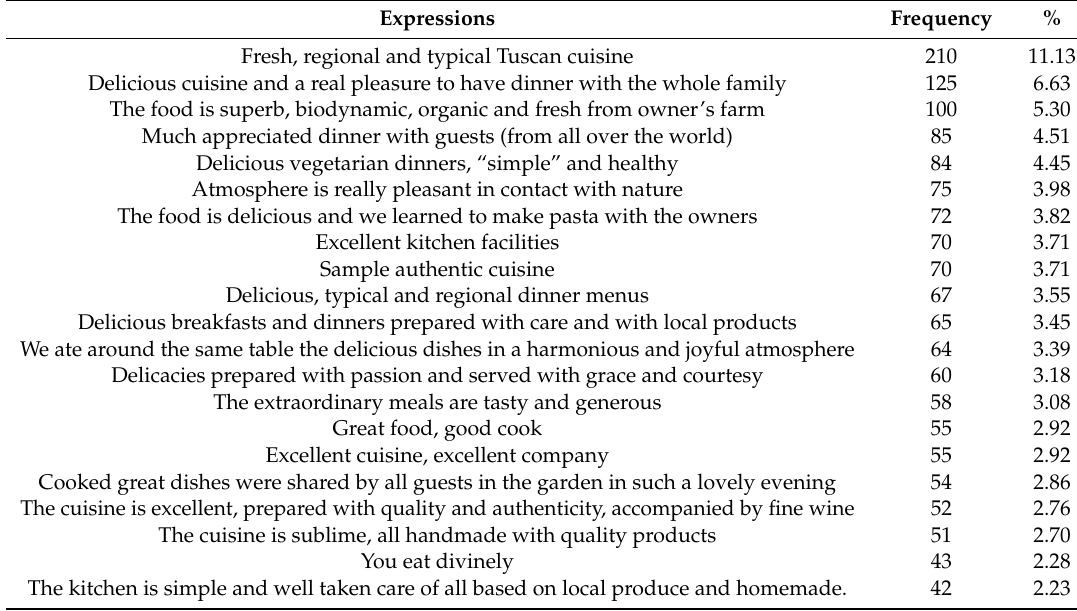
Table 3. Frequently occurring positive comments by